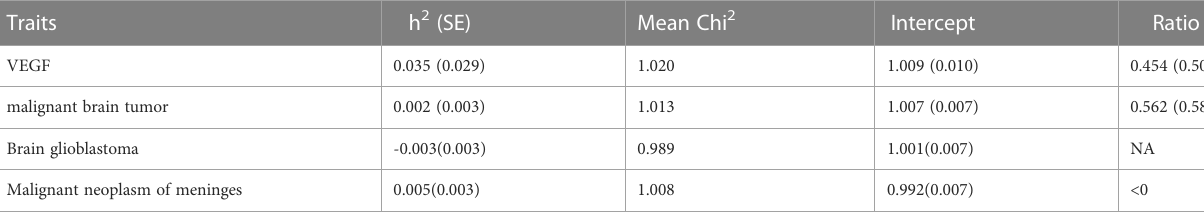
TABLE 2 The heritability of VEGF and different types of malignant brain tumors. Traits